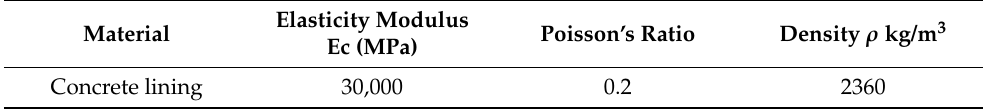
Table 2. Strength parameters of plain concrete lining.